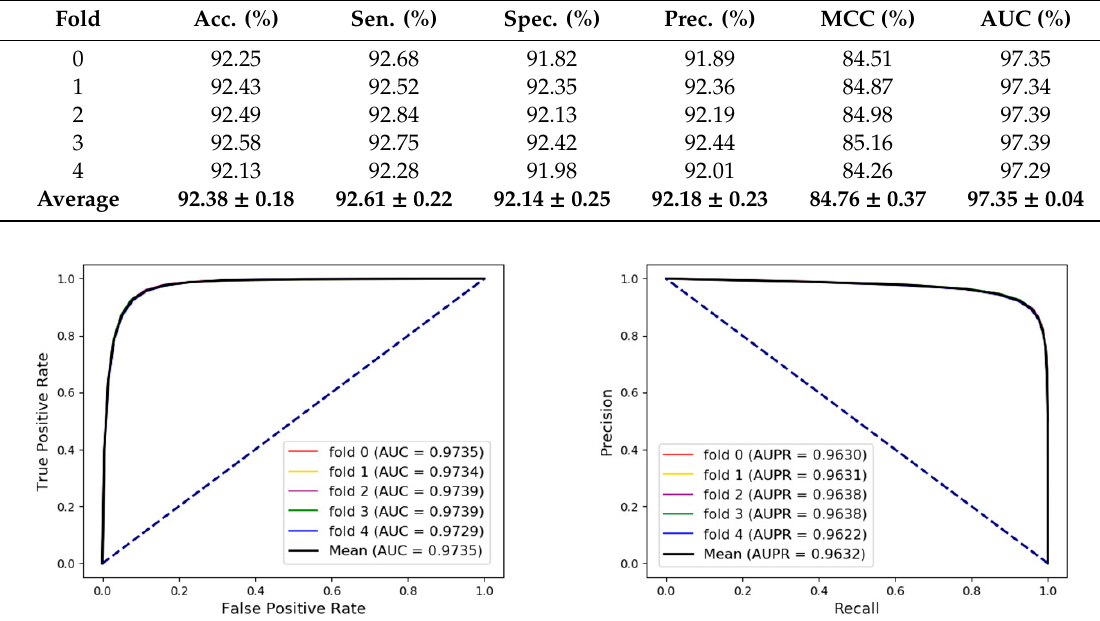
Figure 4. The receiver operating characteristic curves (ROCs), area under curves (AUCs), Precision-Recall Curves (PRs), and area under PRs (AUPRs) of our method under five-fold cross validation on the whole dataset. Table 4. Comparison of different features. Table 4. Comparison of di ff erent features.